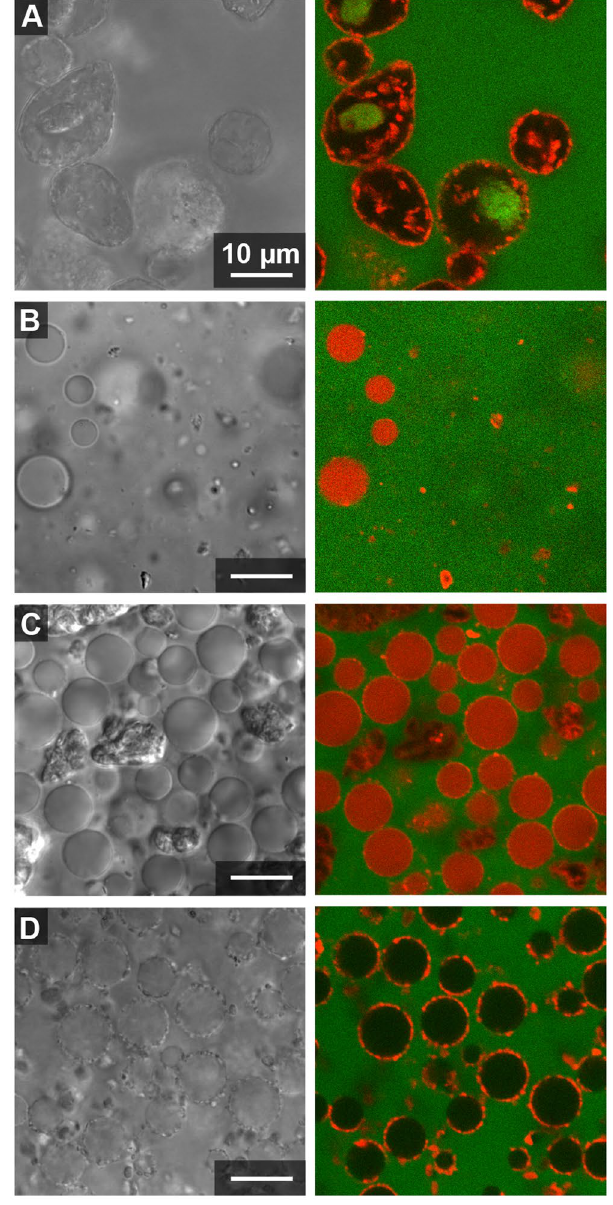
Figure 3. Different volume ratio of ATPS, 20:1 PEG-rich phase: Dx-rich phase from 15%/15% w/w PEG-Dx stock ATPS. Confocal Microscope images of clay particles with fluorescent-labeled Dx (red) and PEG (green) added to aid visualization of Dx-rich phase droplets and continuous PEG-rich phase. Right images show overlay of fluorescence channels and left images show transmitted light for samples containing: ( A ) Kaolinite, ( B ) Na- rich montmorillonite, ( C ) Ca-rich montmorillonite and ( D ) illite in PEG-Dx